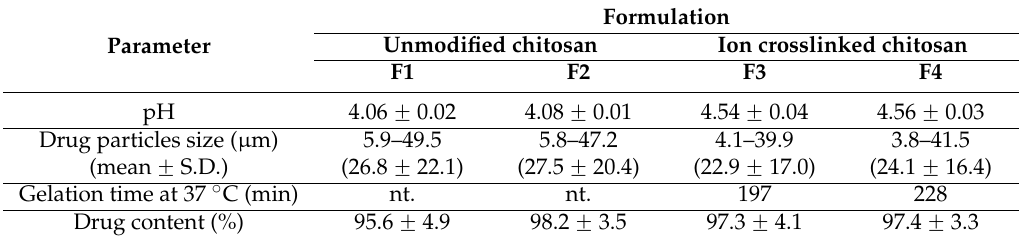
Table 2. Physicochemical parameters of prepared hydrogels with unmodified or β -GP crosslinked CS. nt.—not